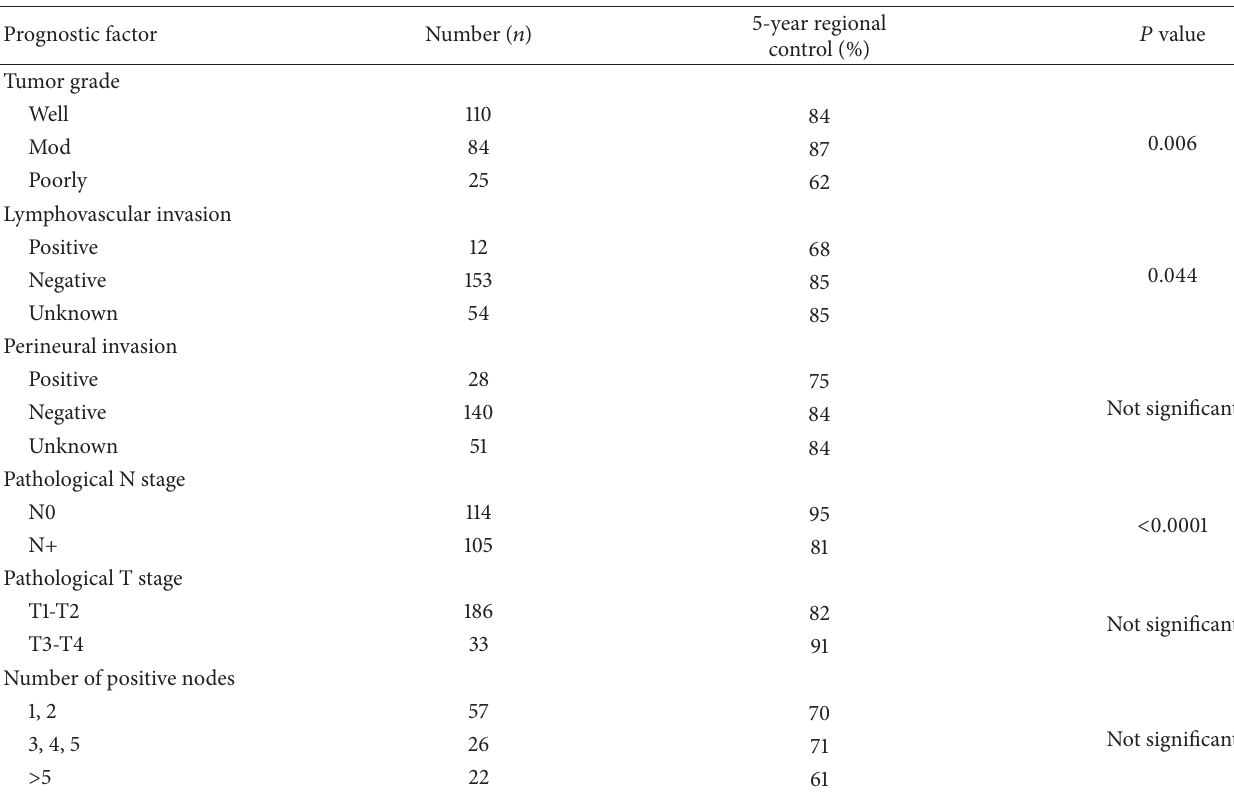
Table 6: Prognostic variables for 5-year regional